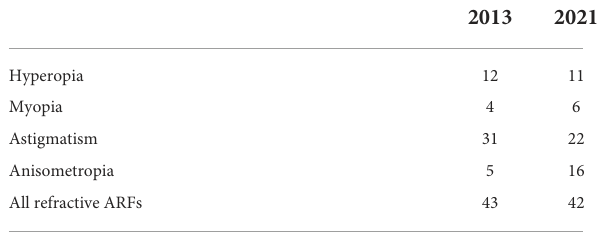
TABLE 1 Comparison of referrals based on the AAPOS 2013 and AAPOS